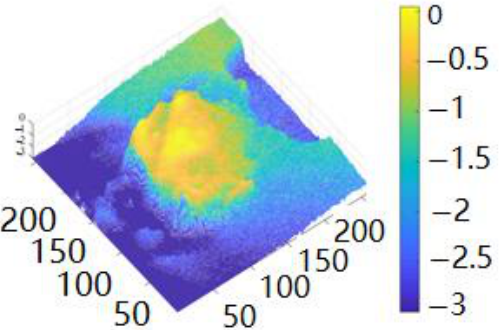
Figure 10. Reconstructing 3D models of silica crystals using the SFS algorithm.